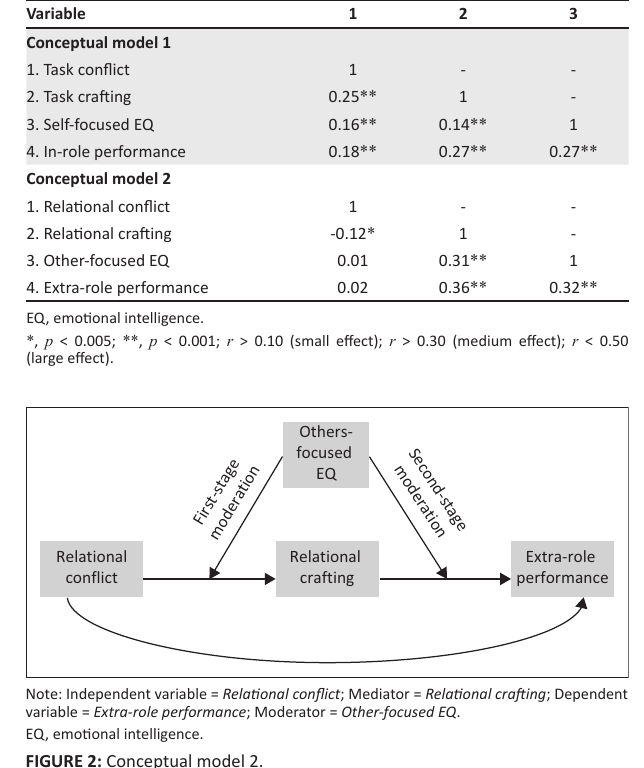
FIGURE 2: Conceptual model